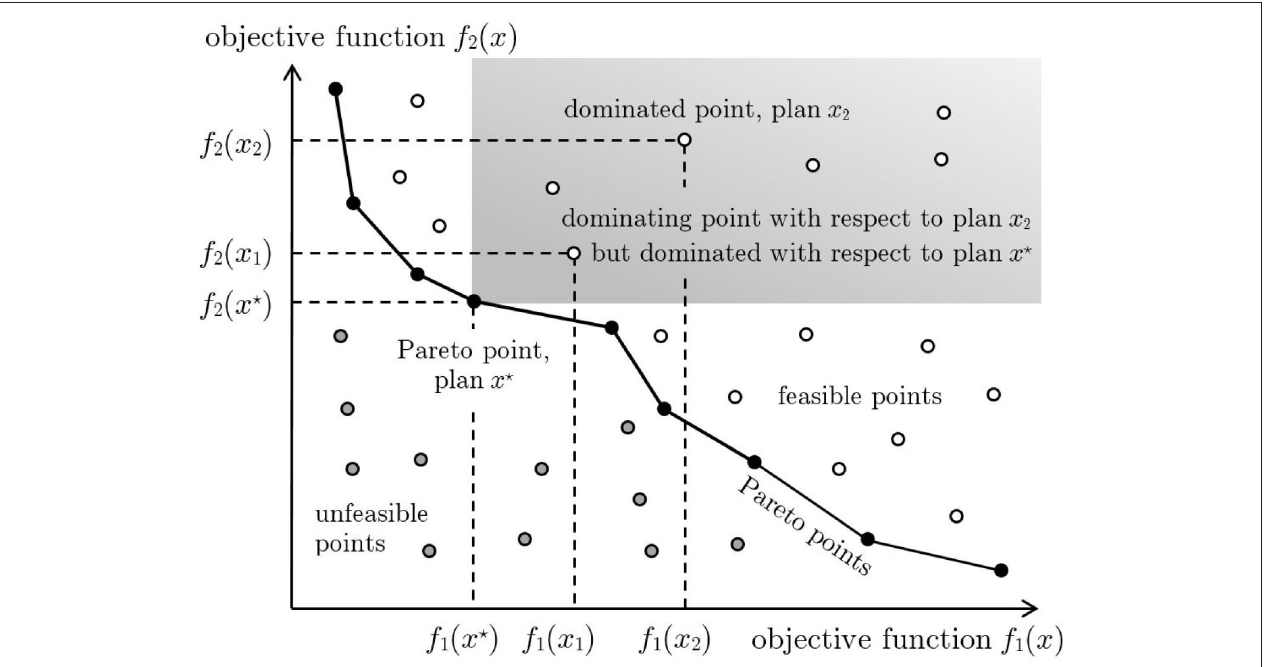
FIGURE 1 | The white circles represent feasible points, that is those corresponding to sustainable plans. The gray circles represent unfeasible points, that is those corresponding to plans that are not sustainable since at least one of the constraints is violated. The black circles represent Pareto points, that is sustainable plans non-dominated by any other sustainable plan. For example, the sustainable plan x 2 is dominated by the sustainable plan x 1 which, in turn, is dominated by the sustainable plan x ⋆ . The latter cannot be dominated by any other sustainable plan and hence correspond to a Pareto point. All the sustainable plans dominated by x ⋆ fall within the gray